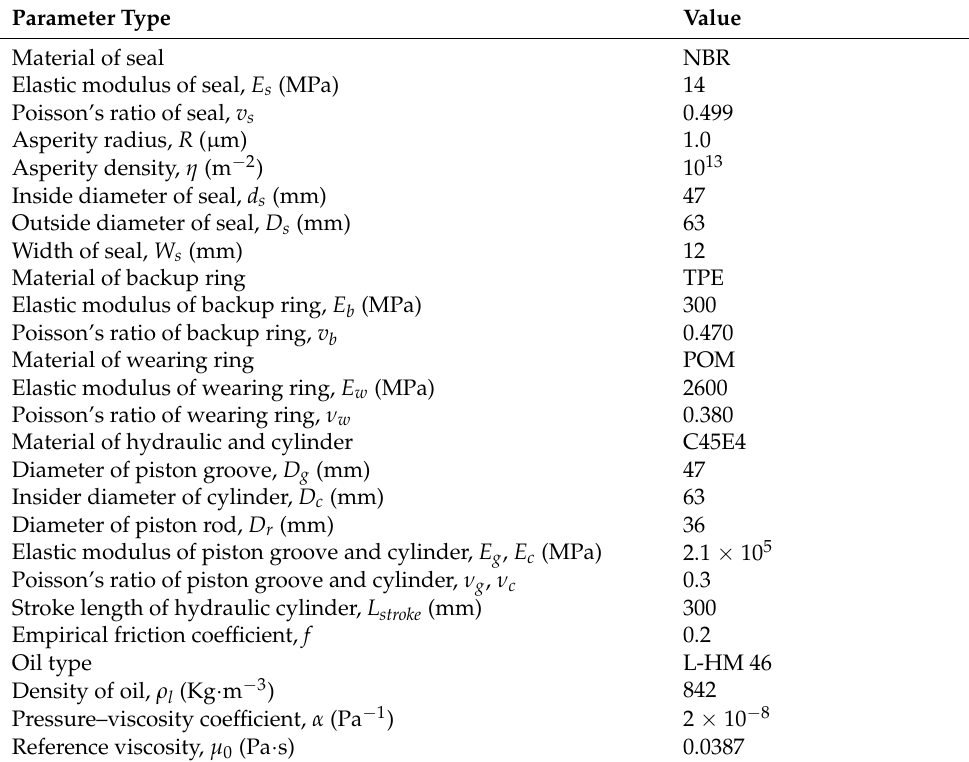
Table 2. Basic parameters of the DAS sealing system.